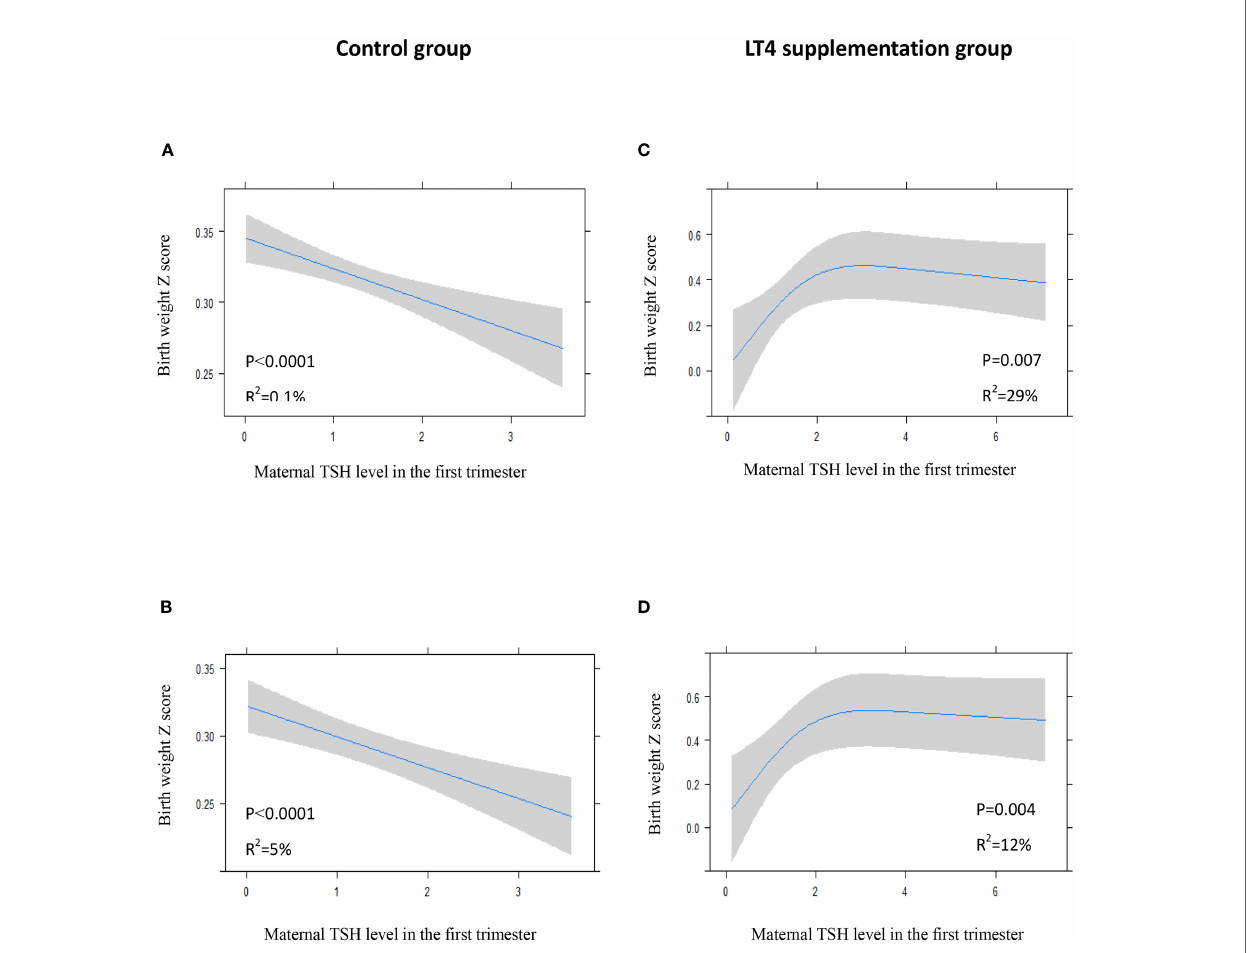
FIGURE 5 | Plots show the association of maternal TSH level in the fi rst trimester with birth weight of total study newborns in control group (A, B) and LT4 supplementation group (C, D) as predicted mean (blue line) with 95% con fi dence interval (CI, gray area). The neonatal birth weight was standardized for Z score. Crude model (A, C) : without adjustment for potential confounders. Adjusted model (B, D) : analyses were adjusted for gestation age at birth, maternal age, body mass index (BMI), pregnancy-induced hypertension (PIH), gestational diabetes mellitus (GDM), and fetal sex.